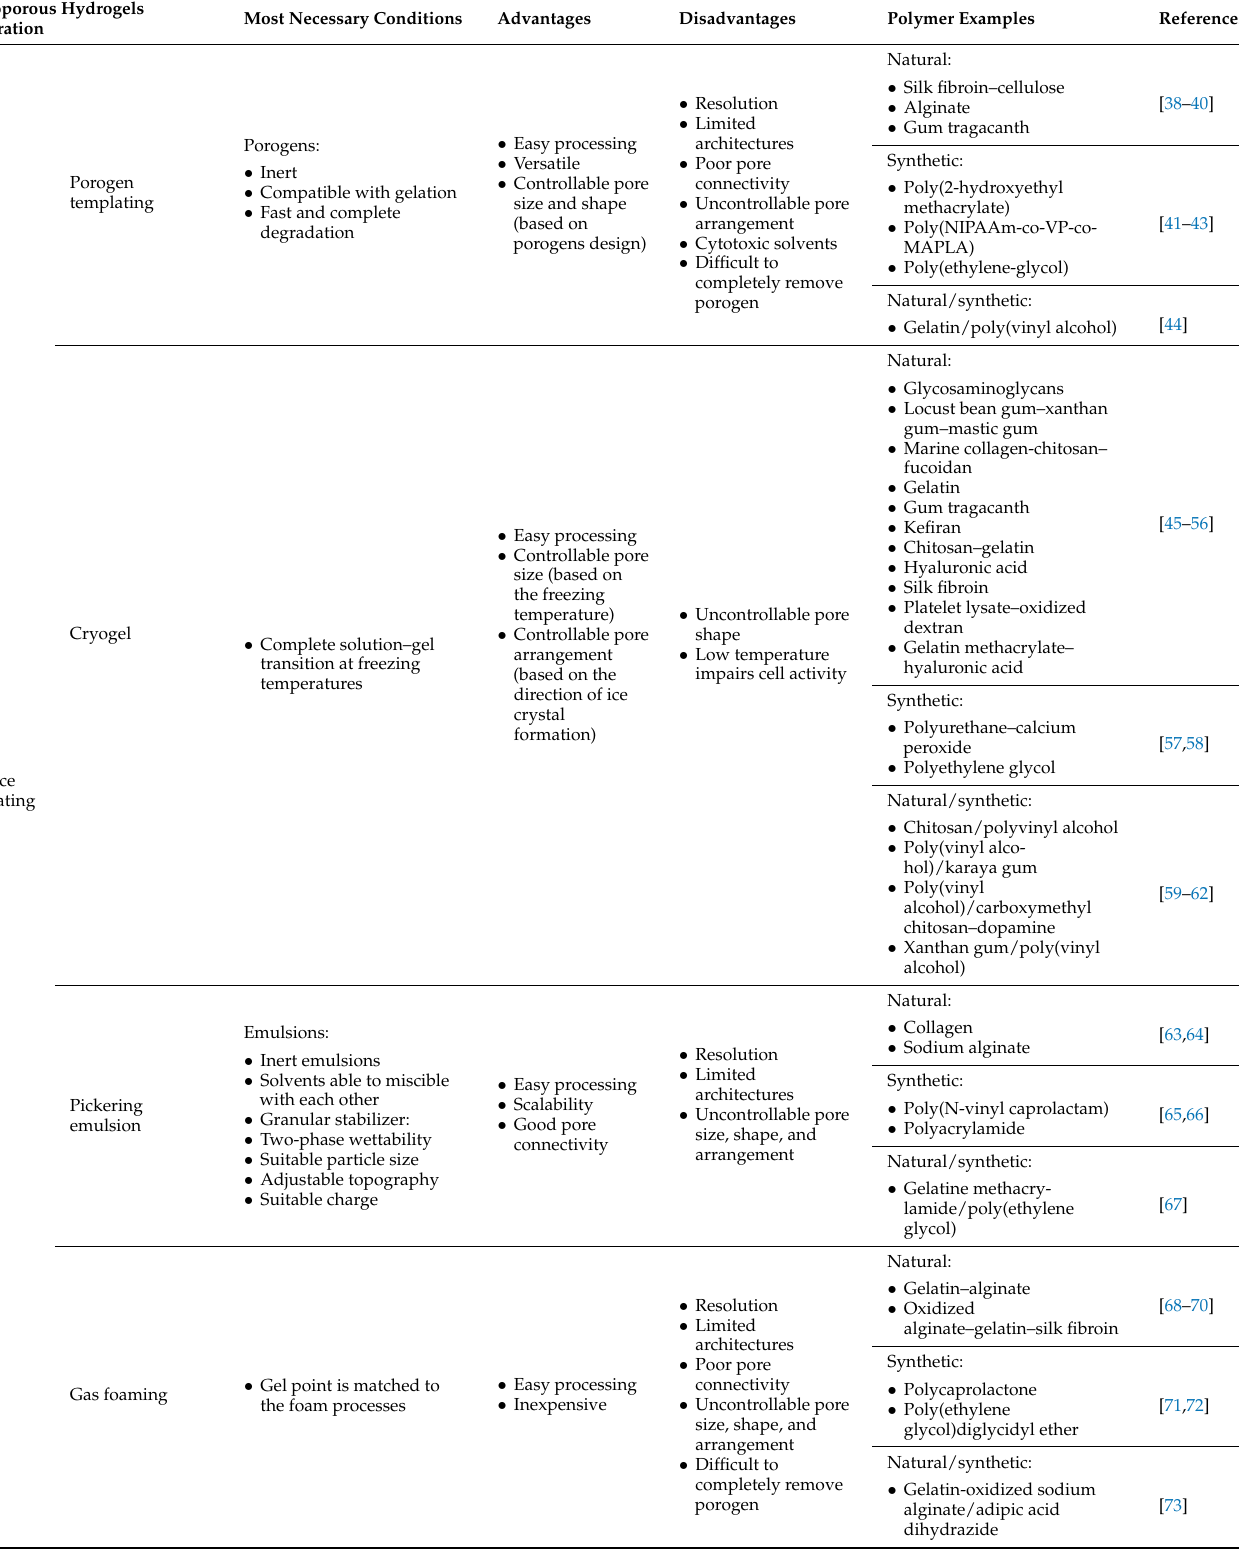
Table 1. Overview of common techniques used to fabricate macroporous hydrogels and their advantages/disadvantages in tissue